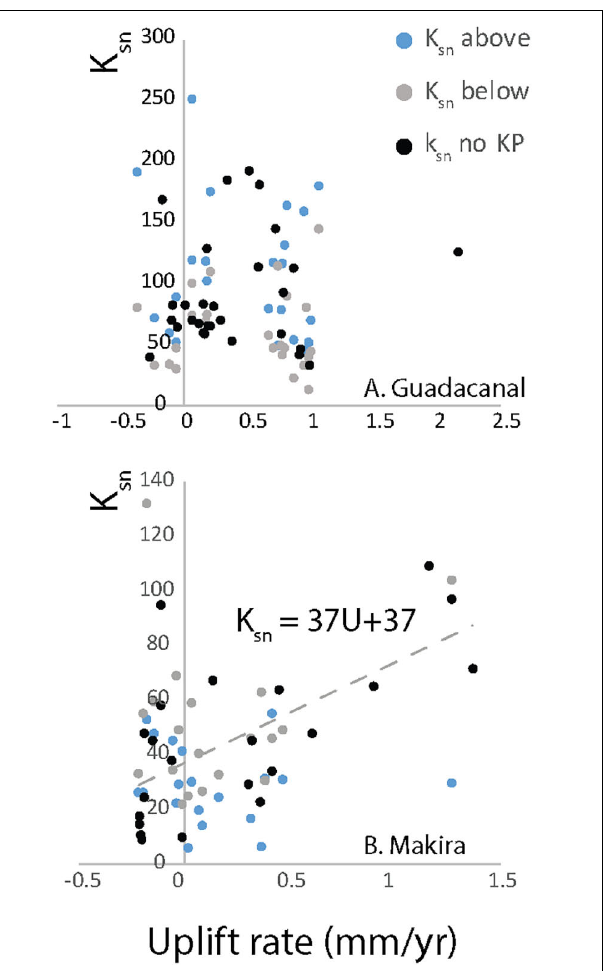
FIGURE 14 | (A,B) Plots of k sn against interpolated uplift rates of the islands of Guadalcanal and Makira, respectively.